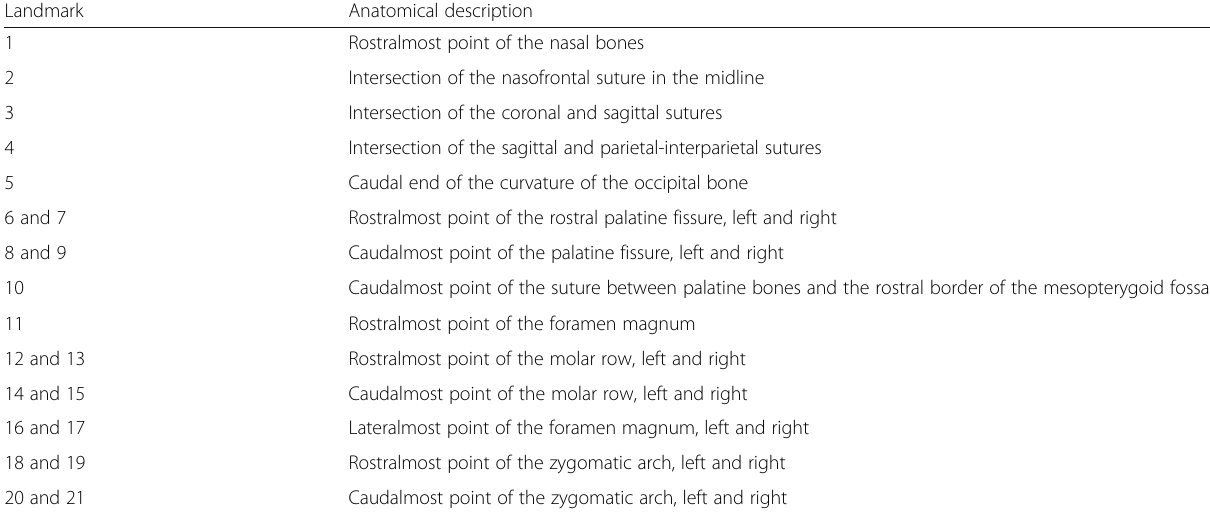
Table 2 Anatomical description of the landmarks used for three-dimensional geometric morphometric analyses. Anatomical description followed to Martínez et al. [32]